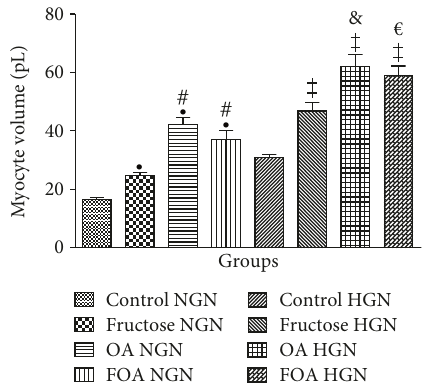
Figure 3: Myocyte volume (pL). NGN: normogonadic; HGN: hypogonadic; OA: oxonic acid; FOA: fructose and oxonic acid. (cid:129) p < 0 0001 fructose, OA, and FOA NGN versus control NGN group. # p < 0 0001 OA and FOA NGN versus fructose NGN group. ‡ p < 0 0001 fructose, OA, and FOA HGN versus control HGN group. & p < 0 01 OA HGN versus fructose HGN group. € p < 0 05 FOA HGN versus fructose HGN group.